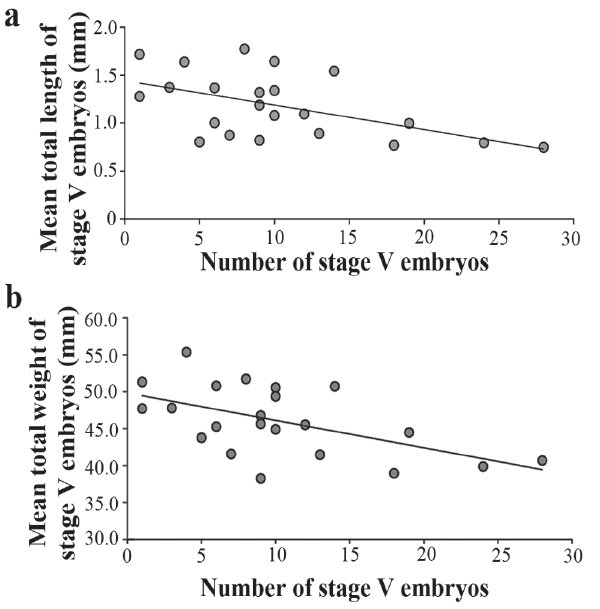
Fig. 10. Embryo length ( a ) and weight ( b ) in relation to the number of stage V embryos in Anableps anableps from the Maracanã River, Pará State.